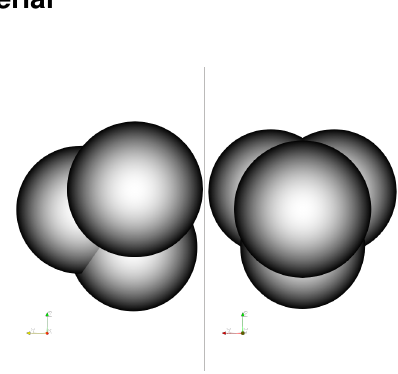
Figure 1. Tetrahedral particle made of clumped spheres